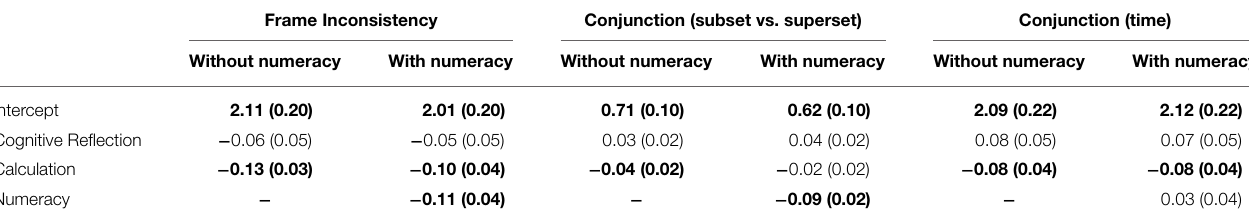
Table A1 | Robust regression results from Study 1 (see Table 5 for linear regression results).